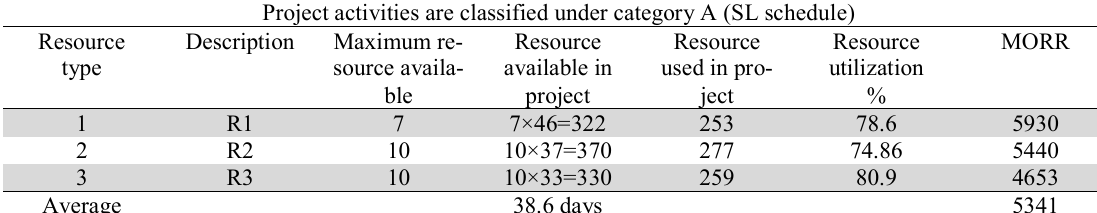
The value of the objective function obtained under SL priority rule for case 1 Project activities are classified under category A (SL schedule)